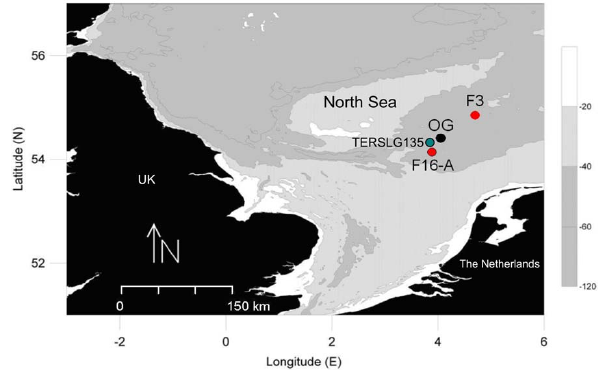
Fig. 1. Location of the CEFAS smartbuoy in the Oyster Grounds (OG, black dot) on a bathymetric map of the North Sea. The KNMI meteorological platforms (F16-A and F3) are also indicated on the map (red dots). The grey dot indicates the location of the Terschelling 135 (TERSLG135) Rijkswaterstaat monitoring point. Modified after Greenwood et al.